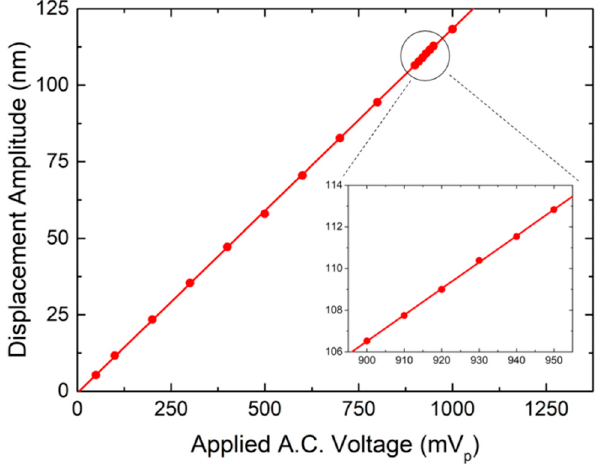
Figure 9. Resolution check for the single crystal stake actuator.